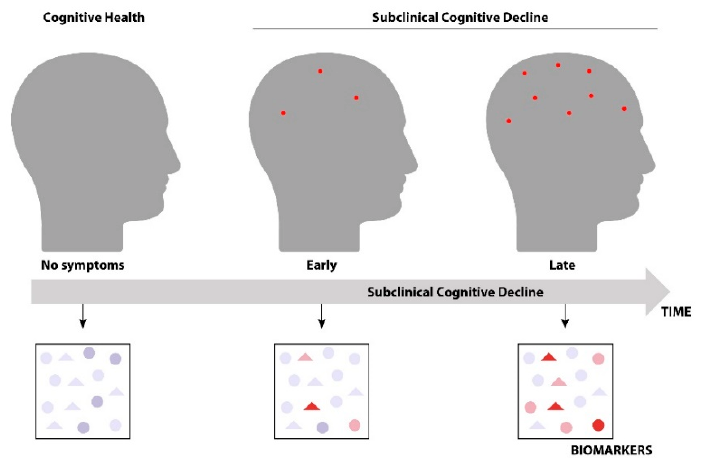
Figure 1. Biomarkers during Subclinical Cognitive Decline. During the subclinical cognitive decline preceding progressive multiple sclerosis, the patients are in early or late subclinical decline, i.e., far from, or closer to, developing progressive multiple sclerosis. A set of distinct biomarkers at these two-time points can provide insight into both diagnosis and treatment. The red dots represent synaptic dysfunction and neurodegeneration, whereas the panels with biomarkers indicate representative differences in biomarkers and distinctive signatures.